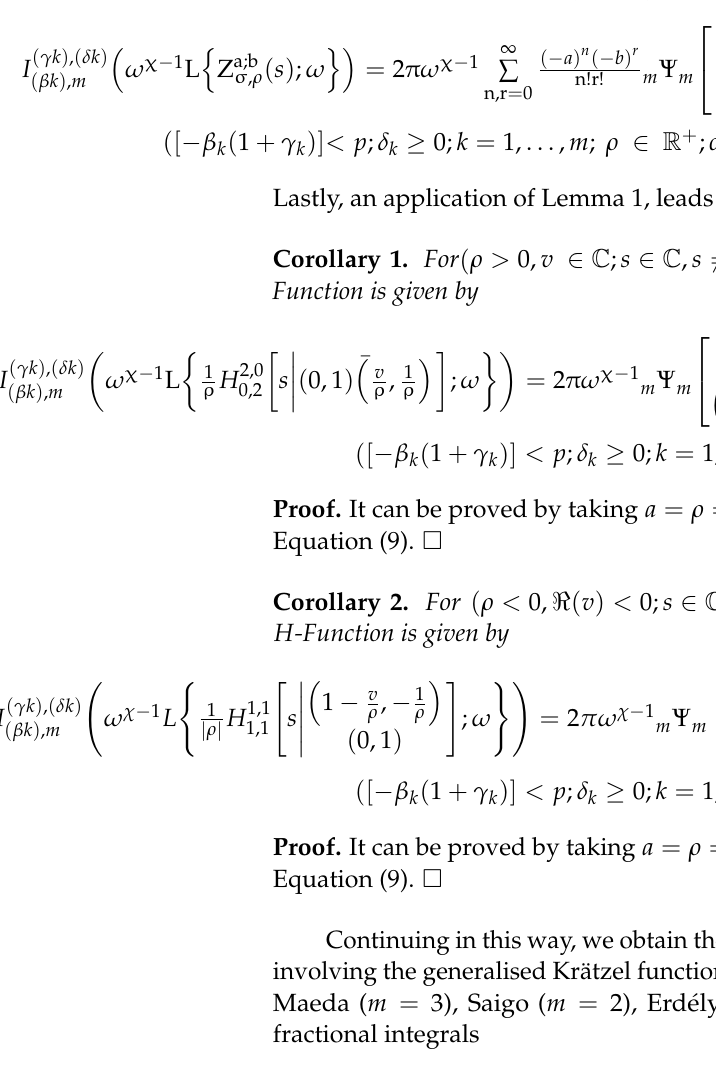
Table 2. Fractional integrals formulae involving the generalised Krätzel function Z a;b σ , ρ ( s ) and H